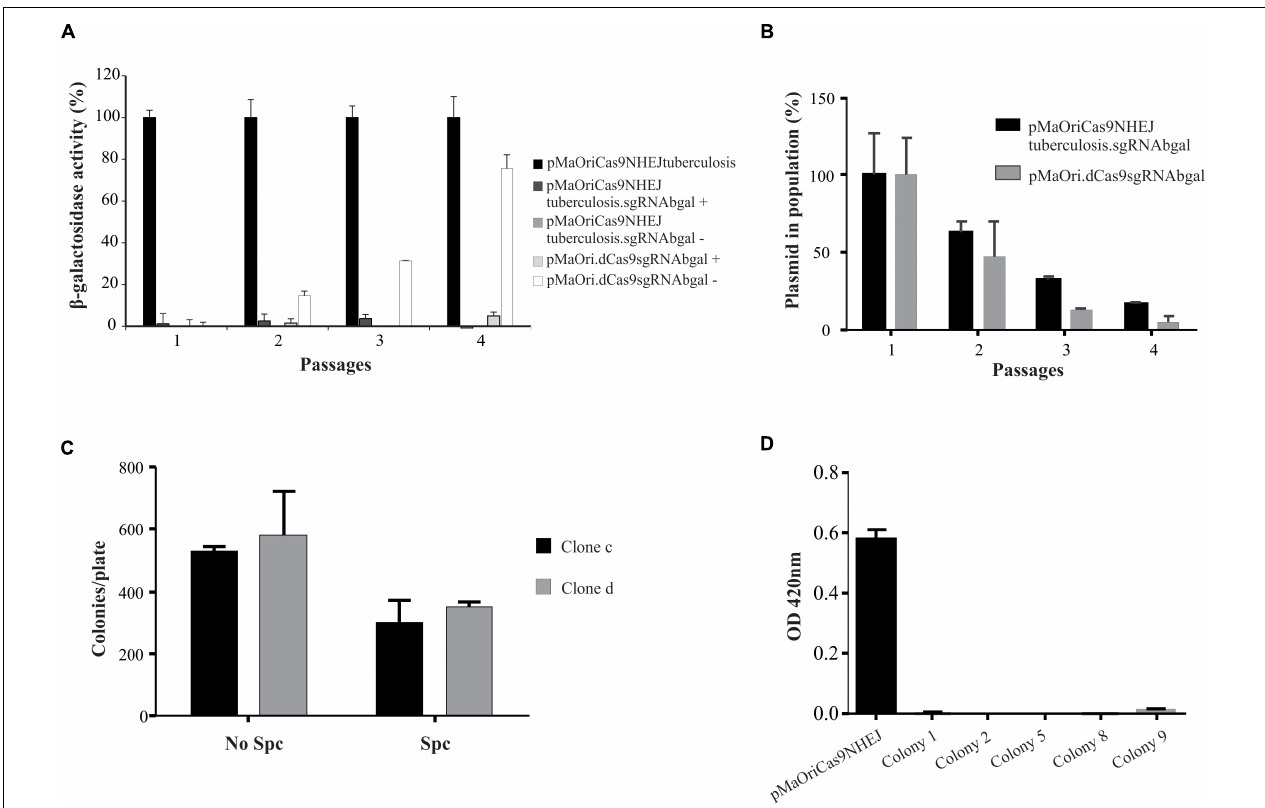
FIGURE 3 | Evaluation of phenotypic stability and plasmid elimination from mutant cells. (A) Two clones from each group were selected for serial in vitro passages in media with (+) or without (–) spectinomycin. Values are expressed in average plus standard deviation (SD) from β -galactosidase activity displayed by both clones, and values from pMaOriCas9NHEJtuberculosis at each passage were considered 100%. (B) Cells were also evaluated by qPCR targeting the plasmid to denote its loss at each passage. After quantitative assessment of plasmid, cultures grown in the absence of antibiotic were seeded onto EMJH plates, with or without spectinomycin (Spc), counted (C) , and 10 colonies from clone “c” plate without Spc were randomly selected and grown in liquid media with or without Spc. Colonies that grew exclusively when Spc was omitted (colonies 1, 2, 5, 8, and 9) were revalidated for β -galactosidase activity by using ONPG substrate (D)